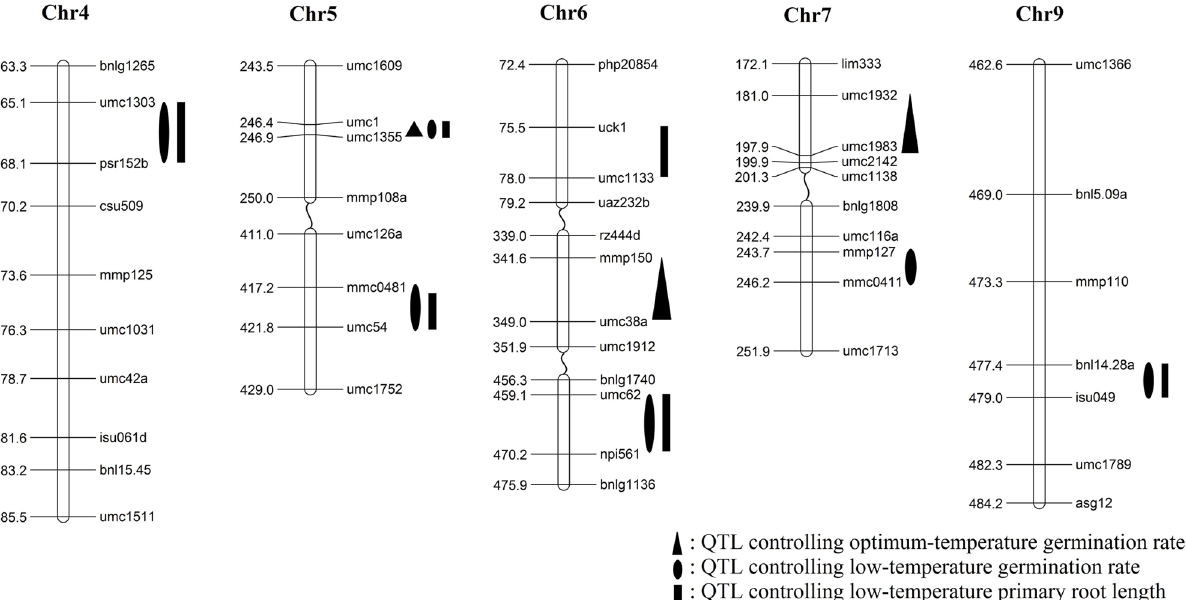
Fig 2. Chromosomal location of quantitative trait loci (QTL) for germination ability under low and optimum temperature conditions in IBM Syn4